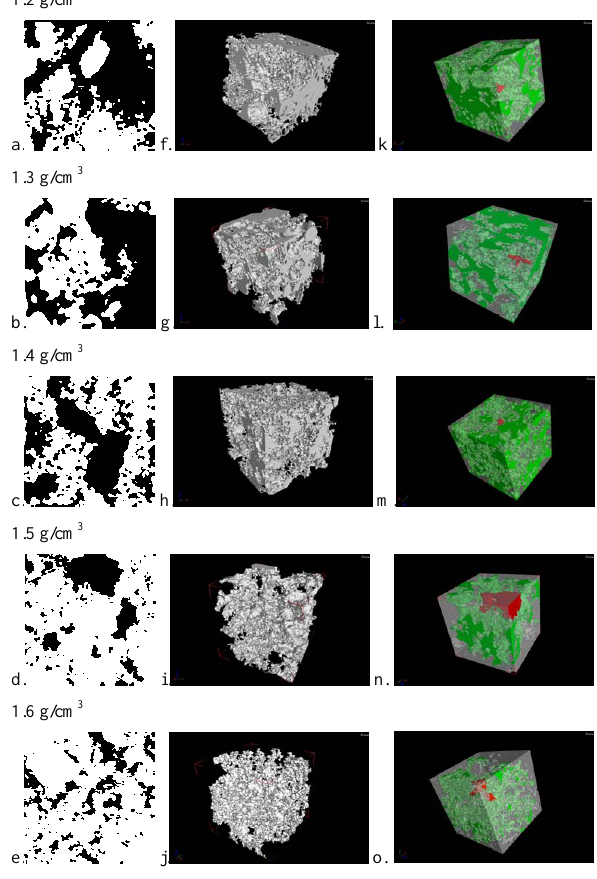
Fig. 2. Pore space visualisation – a–e : thresholded 2-D slices of subsamples (white-solid, black-pore), f–j : whole pore space in 3-D as visualized with X-ray CT, k–o ) 3-D view of subsample with the largest connected pore (green), the second largest connected pore (red) and the remaining pore space (bright gray). One representative examples is shown for each of the density treatments